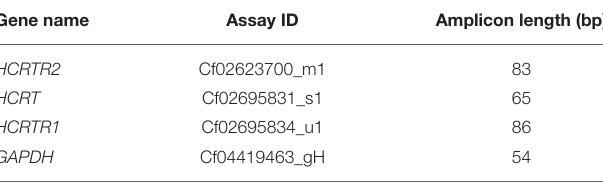
TABLE 1 | List of Taqman assays for real time